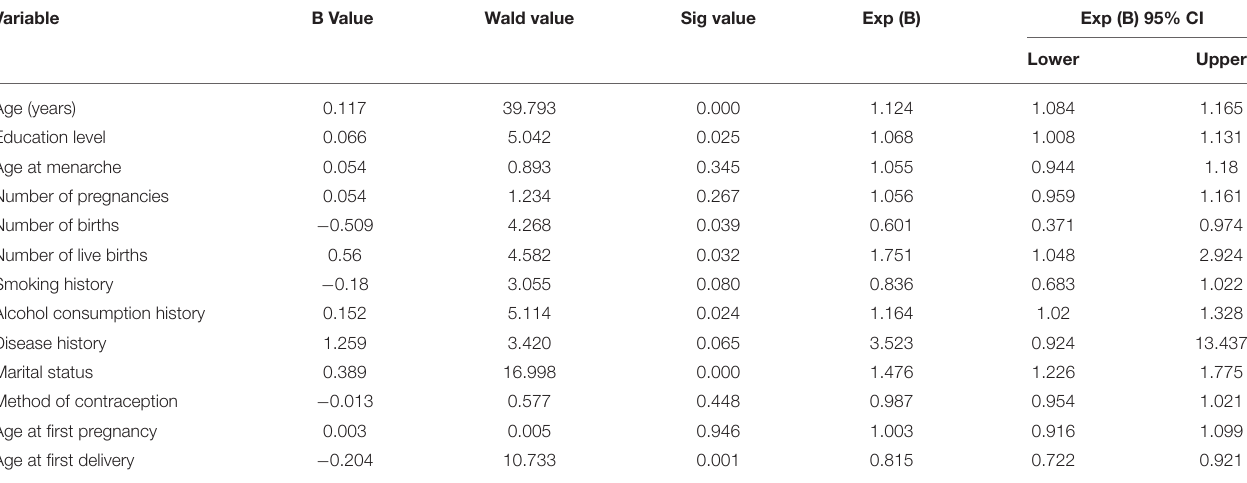
TABLE 4 | Multivariate logistic regression analysis of factors associated with high-risk HPV infection. Variable